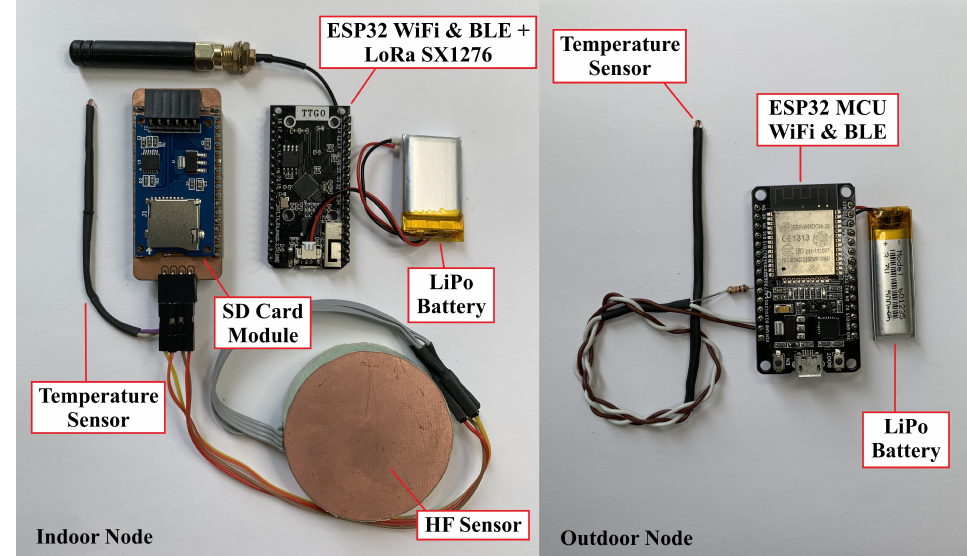
Figure 4. Photograph of the U-value measurement